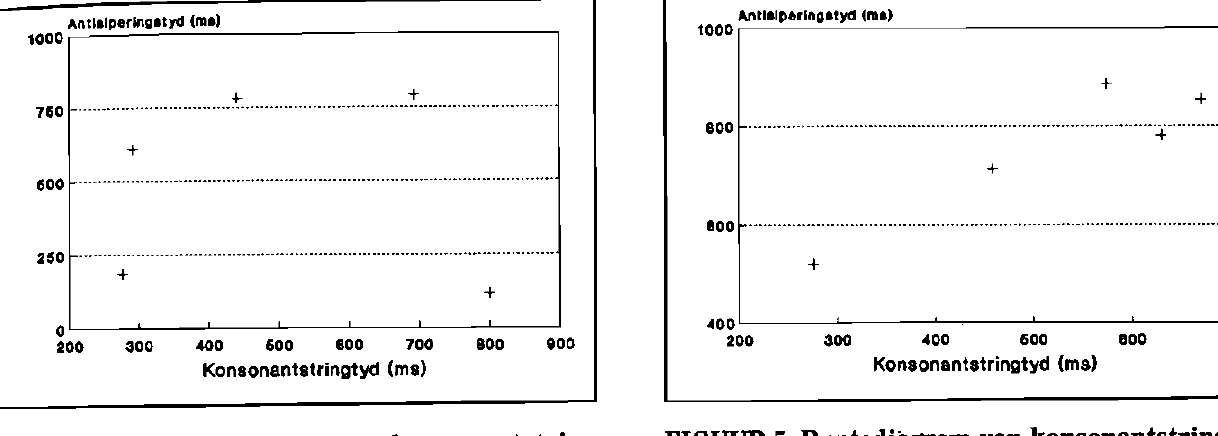
FIGUUR 5: Puntediagram van konsonantstringtyd teenoor antisiperingstyd van eksperimentele materiaalgroep 2 vir proefpersoon